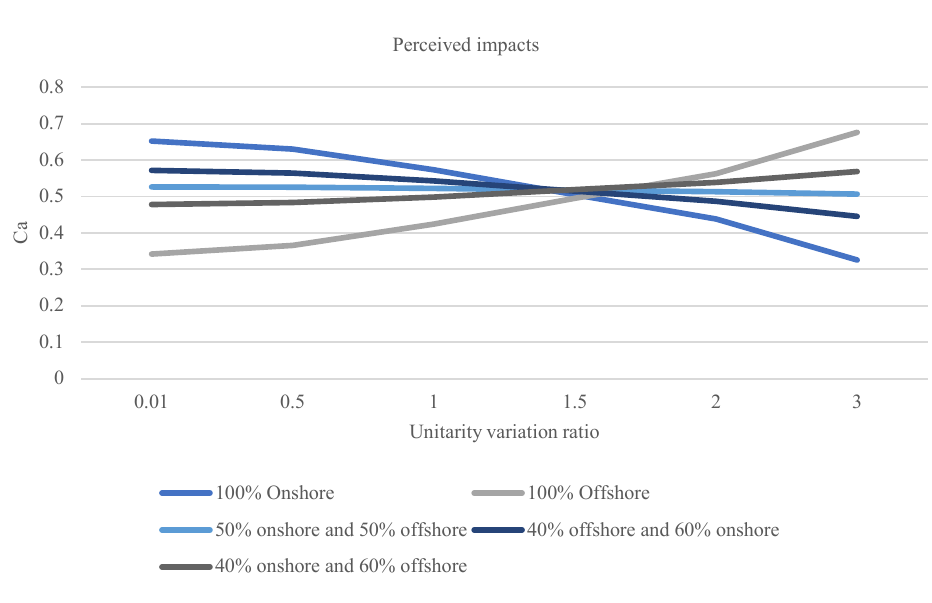
Fig. 5(j). Sensitivity analysis of Perceived